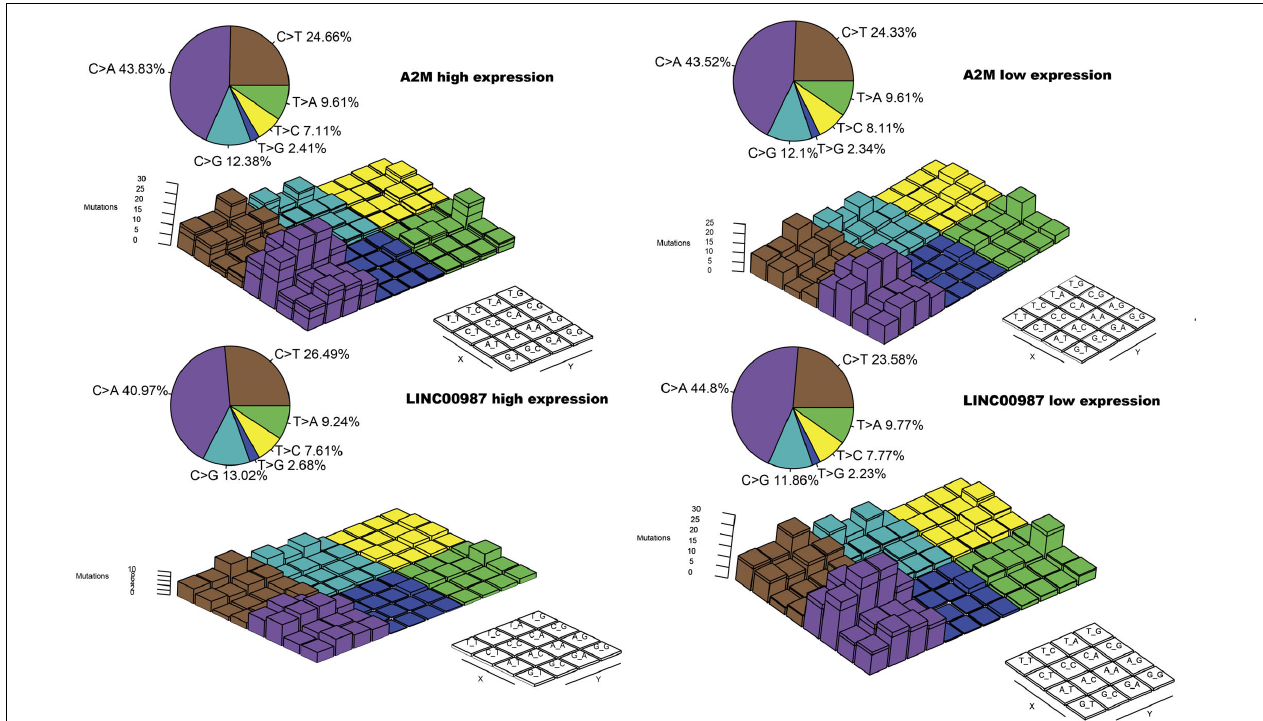
FIGURE 8 | Lego plot representation of mutation patterns in LUAD samples in relation to the LINC00987/A2M axis. Single-nucleotide substitutions are divided into six categories with 16 surrounding flanking bases. The pie chart in the upper left shows the proportion of six categories of mutation patterns.